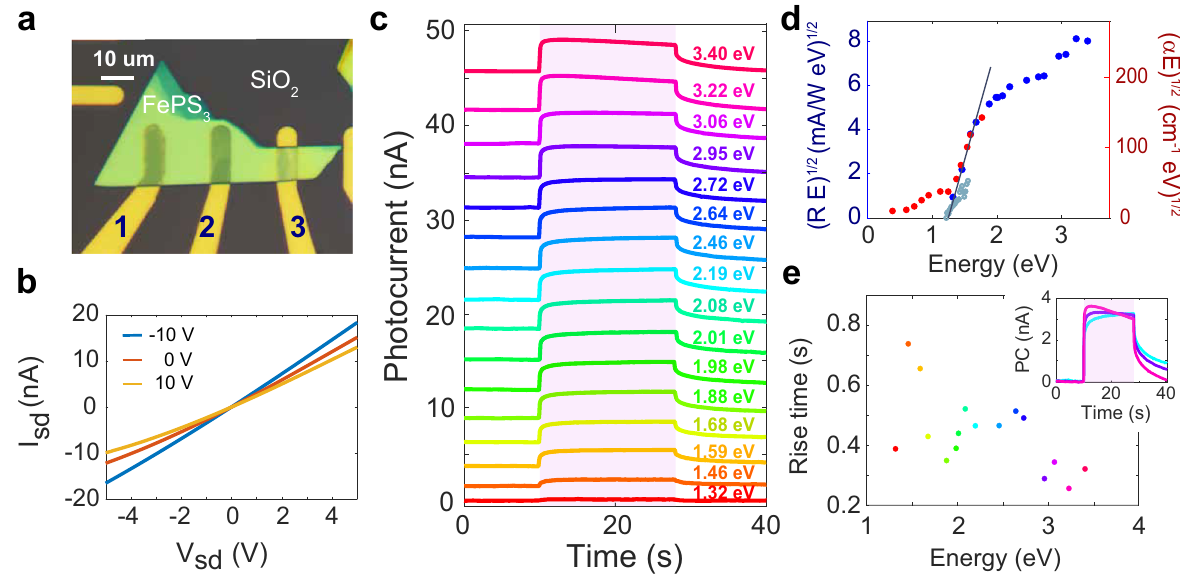
Fig. 2 Electrical and photo-response characterization. a Optical image of device A (30-nm thick) transferred onto a SiO 2 (300 nm)/Si substrate with pre-patterned Ti/Au (10 nm/40 nm) contacts (1 – 3). b Two-terminal source-drain I – V characteristics for different values of the applied gate voltage ( V g = − 10, 0, 10 V), measured between contacts labeled 1 and 2 in ( a ). The increase of current for negative values of V g shows the p-type nature of FePS 3 . c Photocurrent versus time for different optical LED energies ranging from NIR (1.32 eV) to UV (3.40 eV). The shaded area indicates the time when light is ON. The dark current has been subtracted to the values of the drain current during illumination ( I ph = I light − I dark ) for each energy curve. The curves have been vertically offset for clarity. The responsivity of device A extracted from the photocurrent data is represented in ( d ) as an experimental Tauc plot in blue dots, together with a higher resolution set of data (gray dots) and with absorbance measurements of FePS 3 extracted from Brec et al. (red dots) for comparison 11 . The gap energy is determined by the crossing of the linear fi t to the responsivity data (black line) with the x -axis. e Rise time of the FePS 3 phototransistor as a function of different incident energies. The inset compares the trend of the photocurrent over time at low ( E = 2.19 eV, in cyan), medium ( E = 2.95 eV, in purple) and high energies ( E = 3.22 eV, in